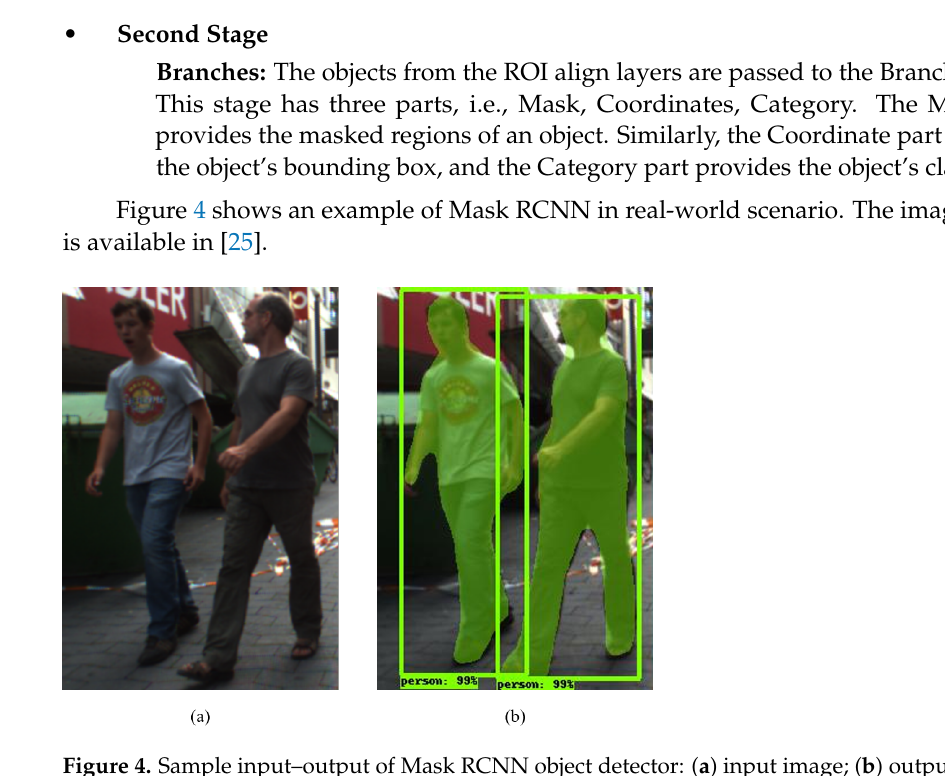
Figure 4. Sample input–output of Mask RCNN object detector: ( a ) input image; ( b ) output